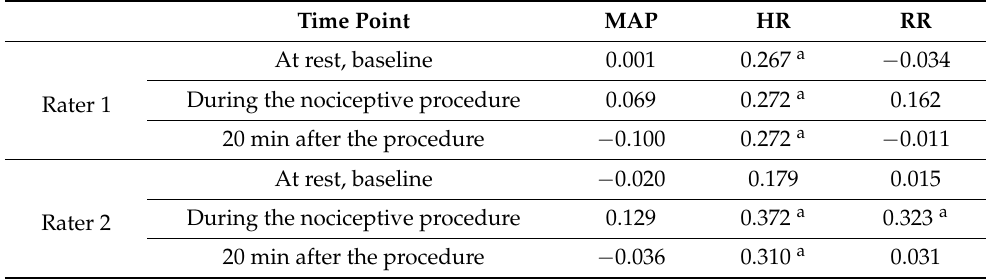
Table 2. Spearman correlations between Critical-Care Pain Observation Tool scores and vital signs for Rater 1 and Rater 2 at each time point.